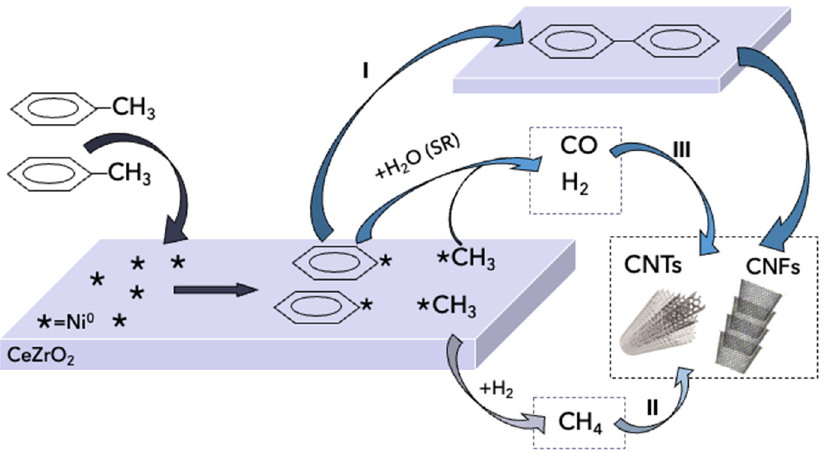
Figure 6. The scheme of CNTs and CNFs formation on the Ni/CeZrO 2 surface during the steam reforming of toluene. Possible routes: I—via biphenyl, II—from CH 4 dehydrogenation, and III–from CO disproportionation.